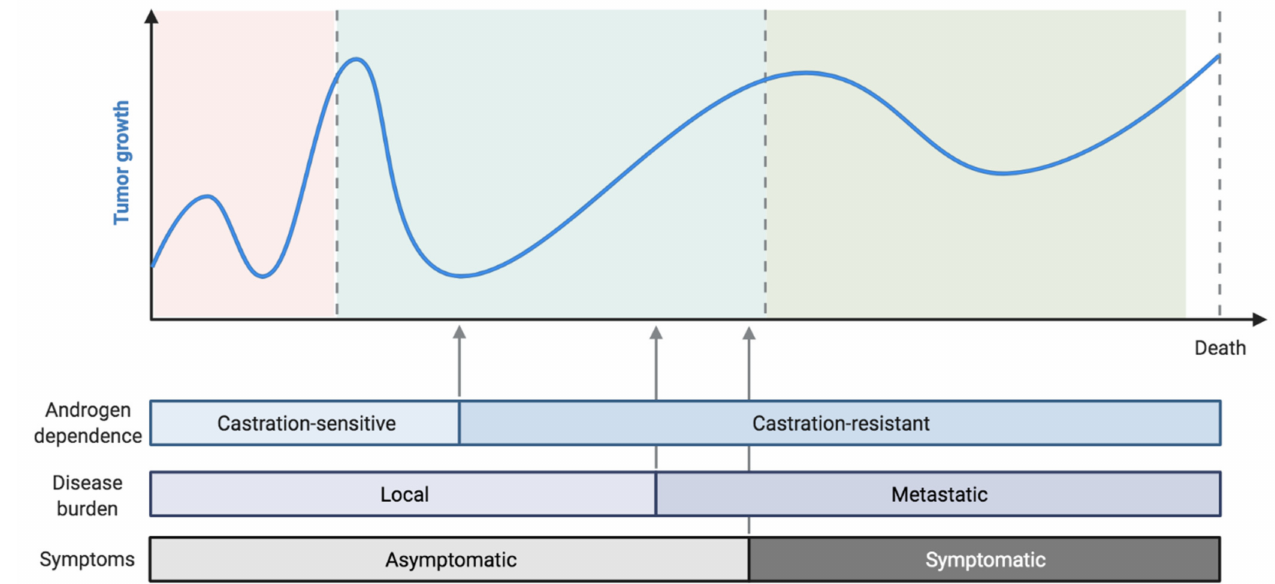
Figure 1. Schematic figure representing the natural history of prostate